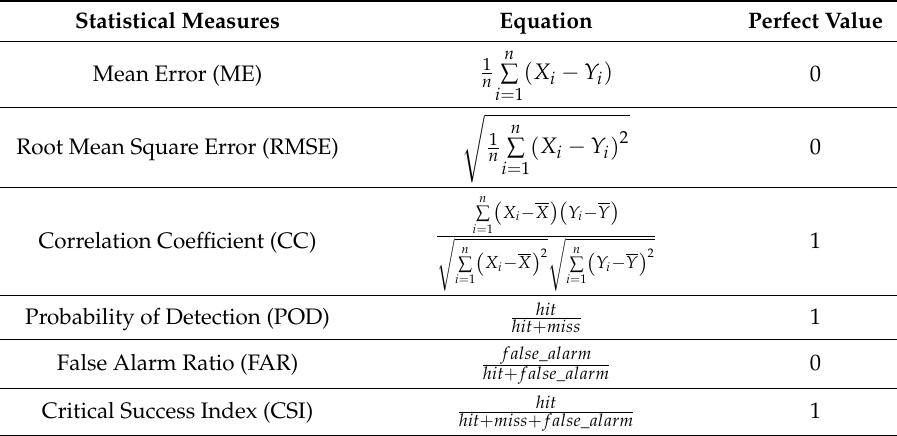
Table 2. List of metrics used in statistical performance measures a